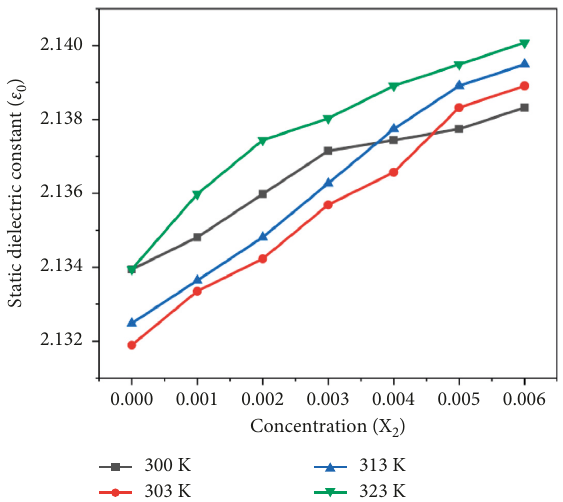
Table 1: The variation of the molar polarization ( P